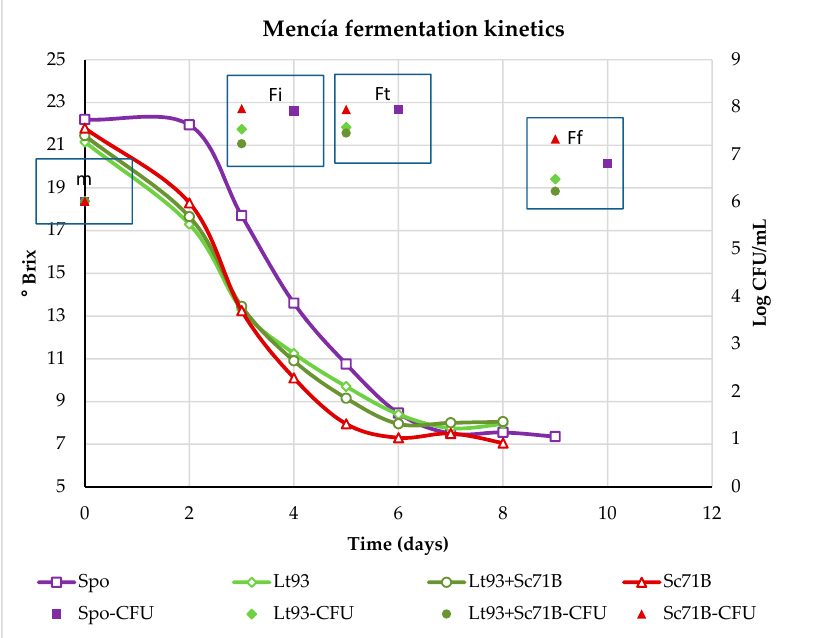
Figure 3 . Evolution of ° Brix and yeast population (CFU/mL) during Mencía fermentations with S. cerevisiae Sc71B and L. thermotolerans Lt93 in monoculture, sequential fermentation (Lt93+Sc71B), and spontaneous process (Spo). m—must; Fi—initial fermentation; Ft—tumultuous fermentation; Ff—final fermentation.